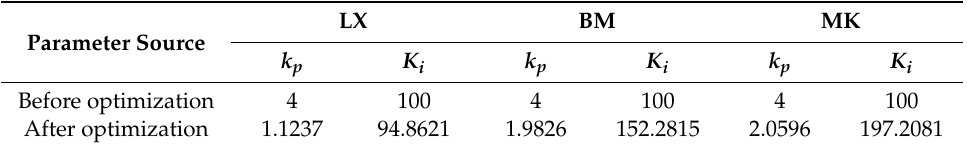
Table 2. The optimized SVC control parameters.